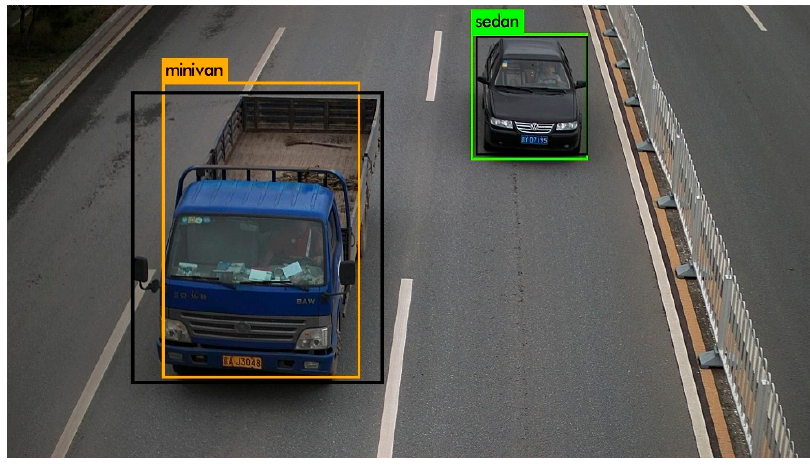
Figure 2. The detection boxes generated by YOLOv2.